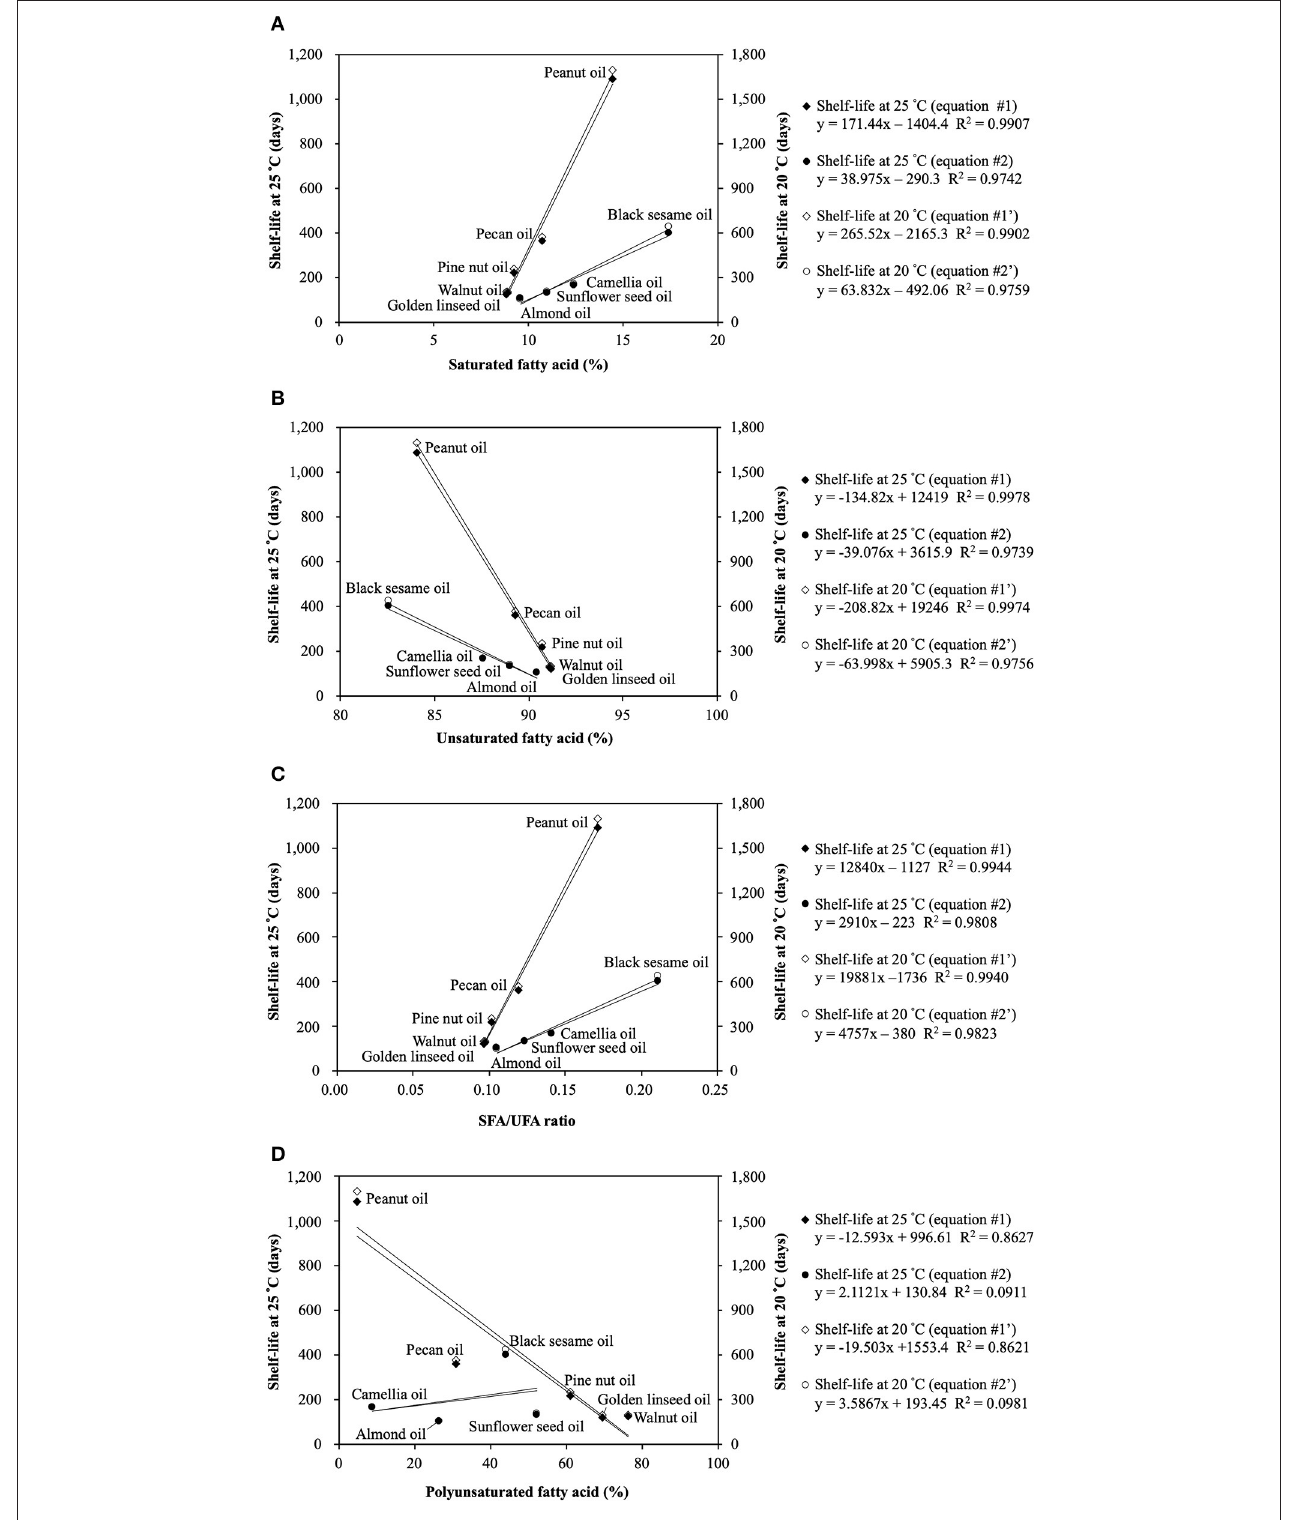
FIGURE 1 | The two-curve models between fatty acid compositions and shelf-lives at 20 and 25 ◦ C: (A) Saturated fatty acid (SFA); (B) Unsaturated fatty acid (UFA); (C) SFA/UFA ratio; (D) Polyunsaturated fatty acid (PUFA).